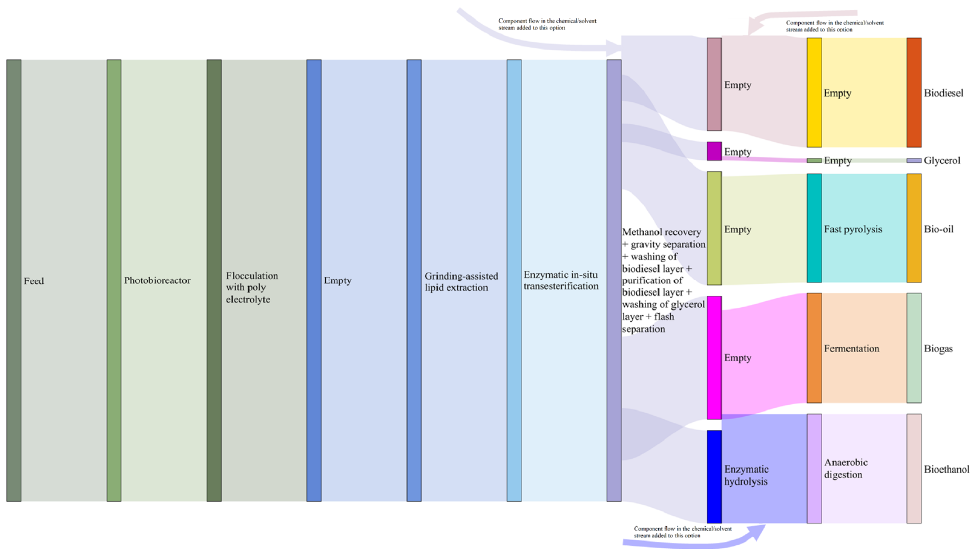
Figure 9. Sankey diagram representing the flows by the proposed method for Scenario 1.